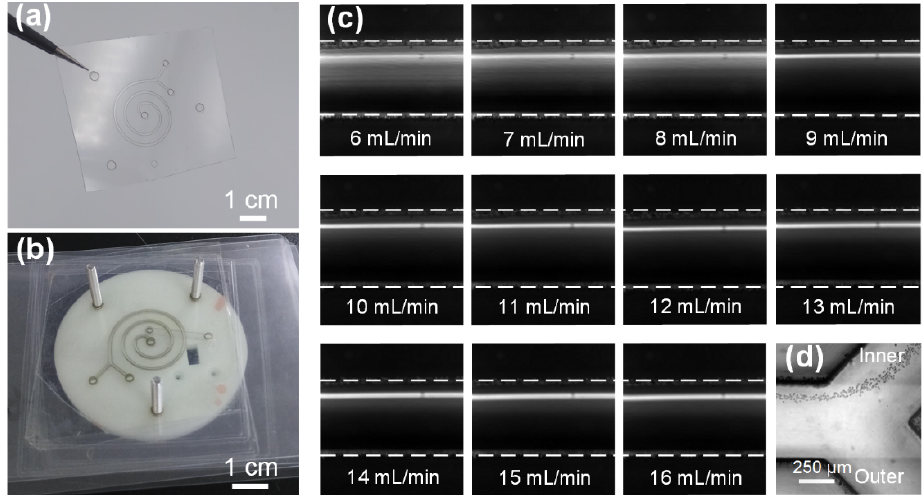
Figure 2. ( a ) Photograph of the single device that was fabricated in polymer films using a rapid process of laser cutting and lamination bonding. ( b ) Photograph of the four-channel paralleled device for ultra-high-flow-rate processing. Four identical channel layers were precisely aligned and vertically stacked with the assistance of locating holes in each channel layer and a corresponding fixture. ( c ) Composite images illustrating the distributions of 10 μ m particles across the channel width near the outlet at the flow rates of 6–16 mL/min with an interval of 1 mL/min. White dotted lines indicate the channel walls. The upper wall is the inner wall. ( d ) Stacked bright field image illustrating the particle focusing at the Y-shaped outlet.